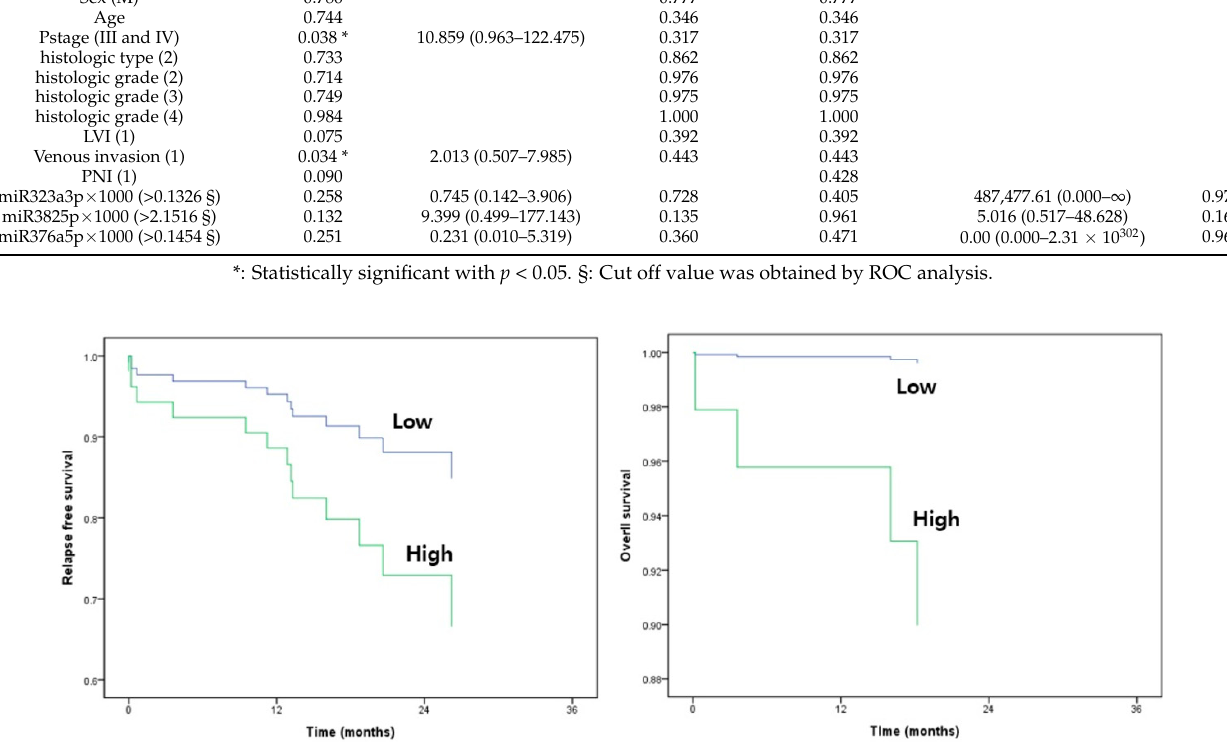
Figure 4. Survival curves for relapse-free survival (RFS) and overall survival (OS) according to three miRNA expression. Table 3. Univariate and multivariate analysis of overall survival.